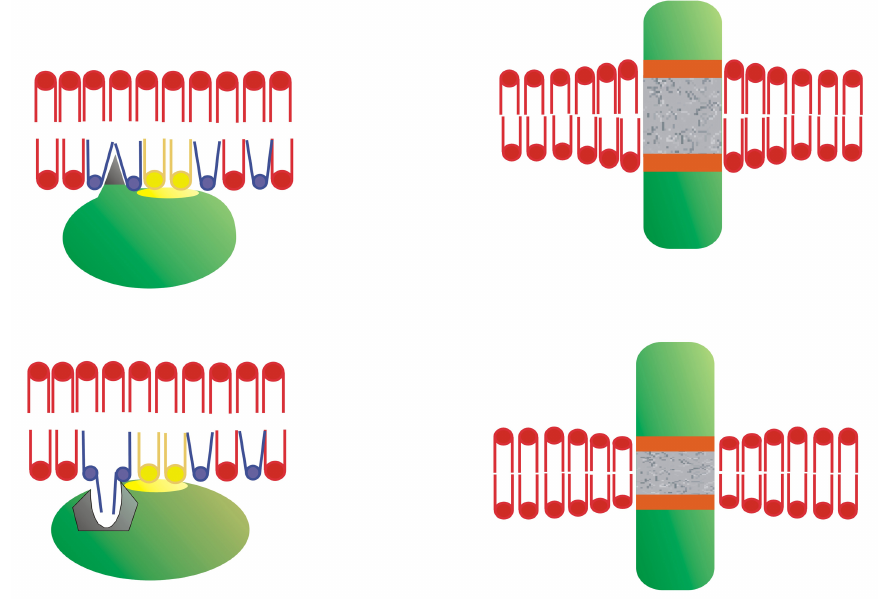
Figure 5. Membrane lipid structure and protein interactions. ( Left ) The interaction of amphitropic peripheral proteins with non-lamellar-prone bilayers with loose surface packing. ( Right ) The Interaction of integral transmembrane-spanning proteins with lipid bilayers. Adapted from Reference